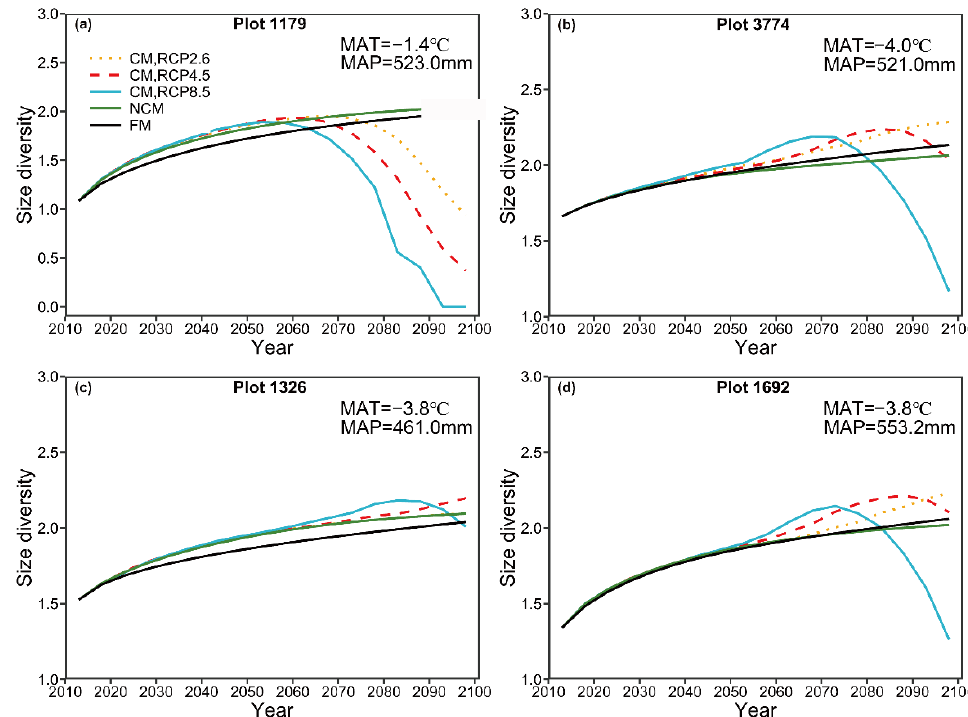
Figure 9. Long-term prediction of size diversity by the climate-sensitive model (CM) under three RCPs, the variable transition model which did not expect climate change (NCM), and the fixed- parameter model (FM), using NFI plots 1179, 3774, 1326, and 1692. The value of the MAT is the mean annual temperature between 2013 and 2018 and MAP represents the mean annual precipitation of the same period.